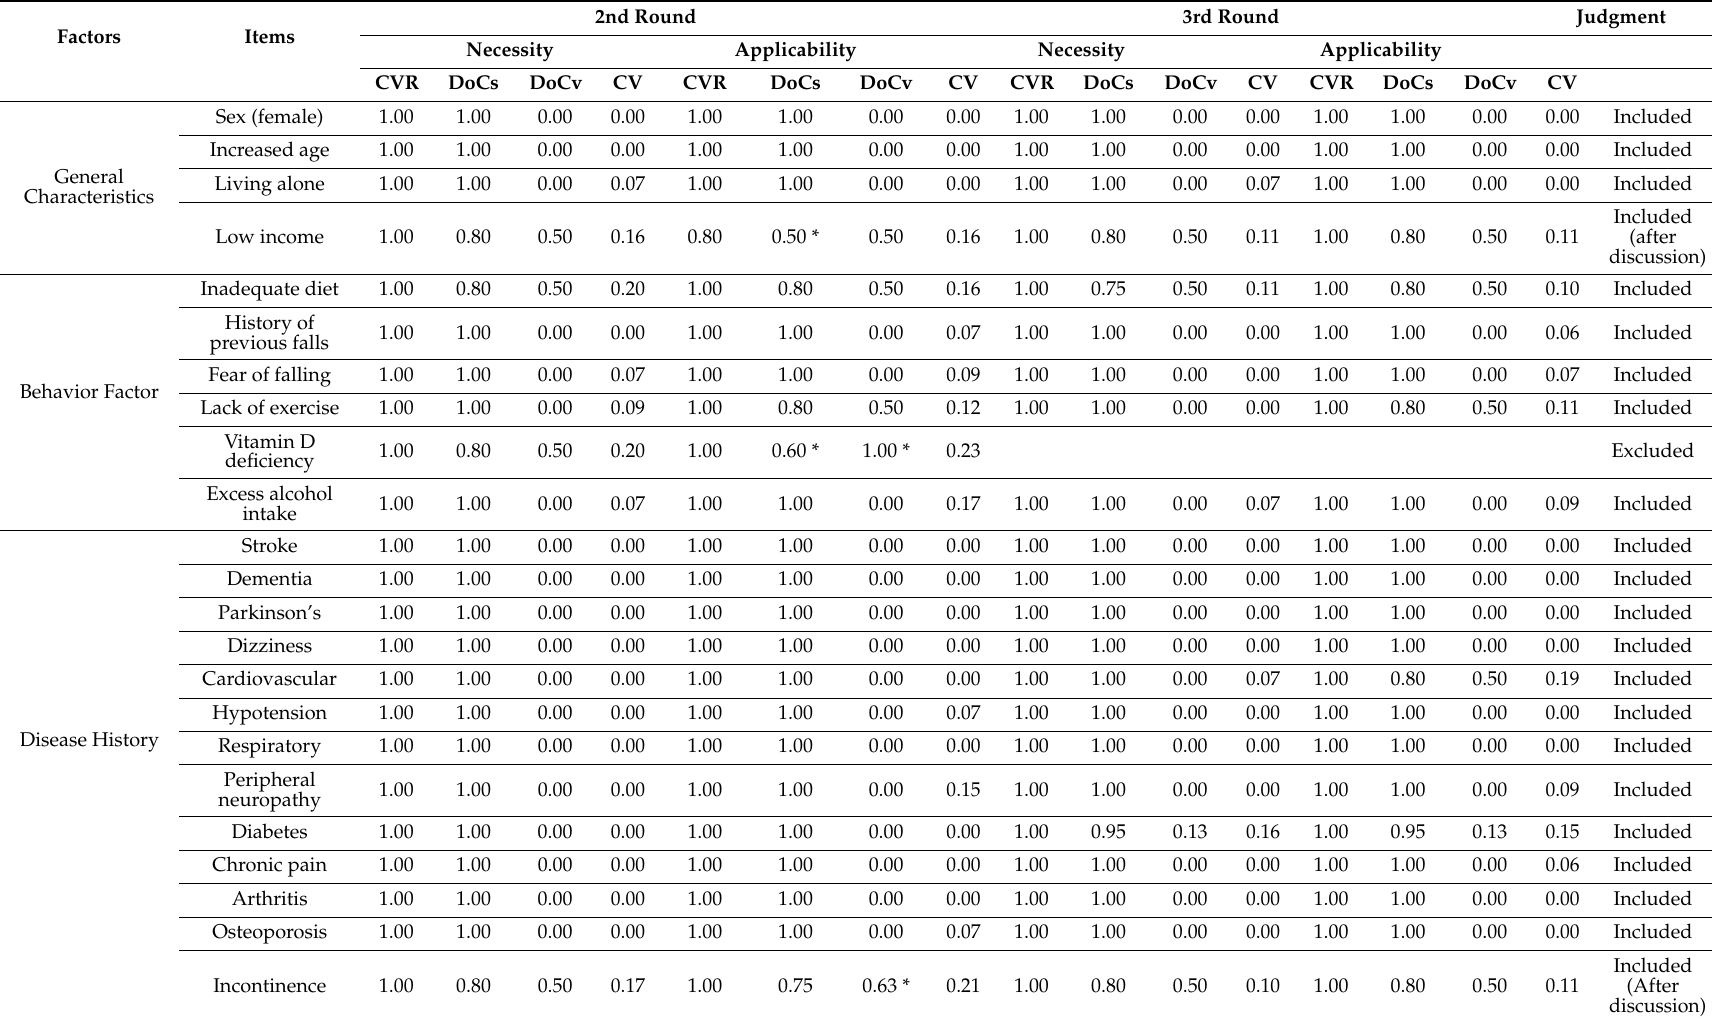
Table 4. Results of the scoring round Delphi survey and the final items of the